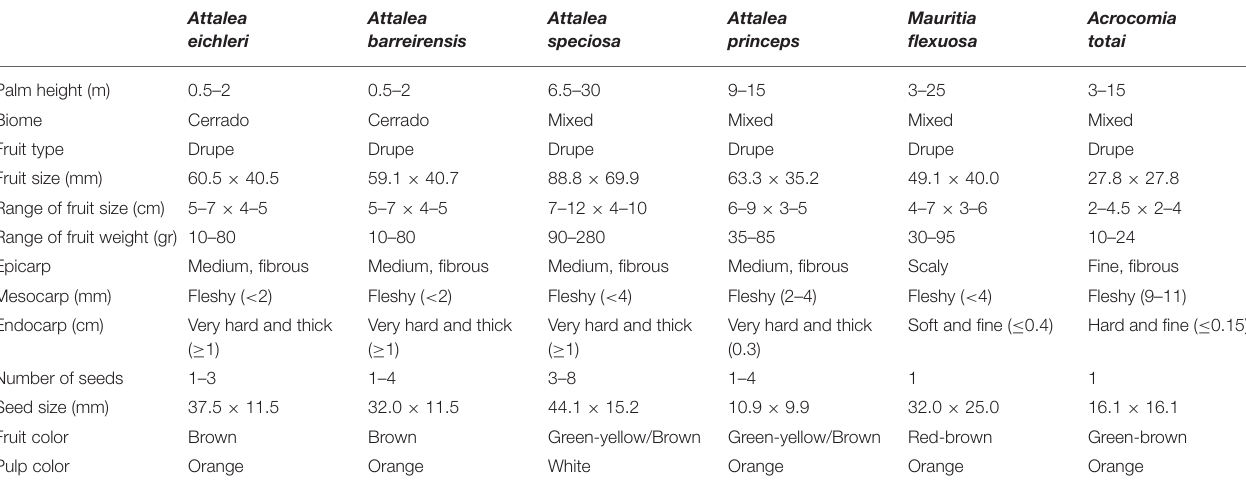
TABLE 2 | Details of the characteristics of the studied palm species, their fruits, and